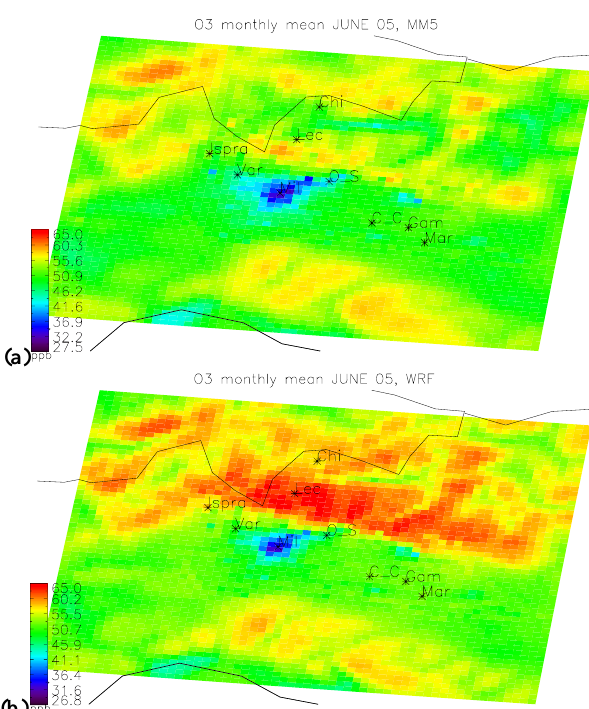
Fig. 5. Monthly mean O 3 concentrations for June by CHIMERE us- ing the MM5 meteorology (a) and WRF meteorology, Noah LSM and YSU PBL (b) . Var=Varese, Lec=Lecco, Chi=Chiavenna, O S=Osio Sotto, C C=Corte di Cortesi, Gam=Gambara, Mar=Marmirolo Fontana,